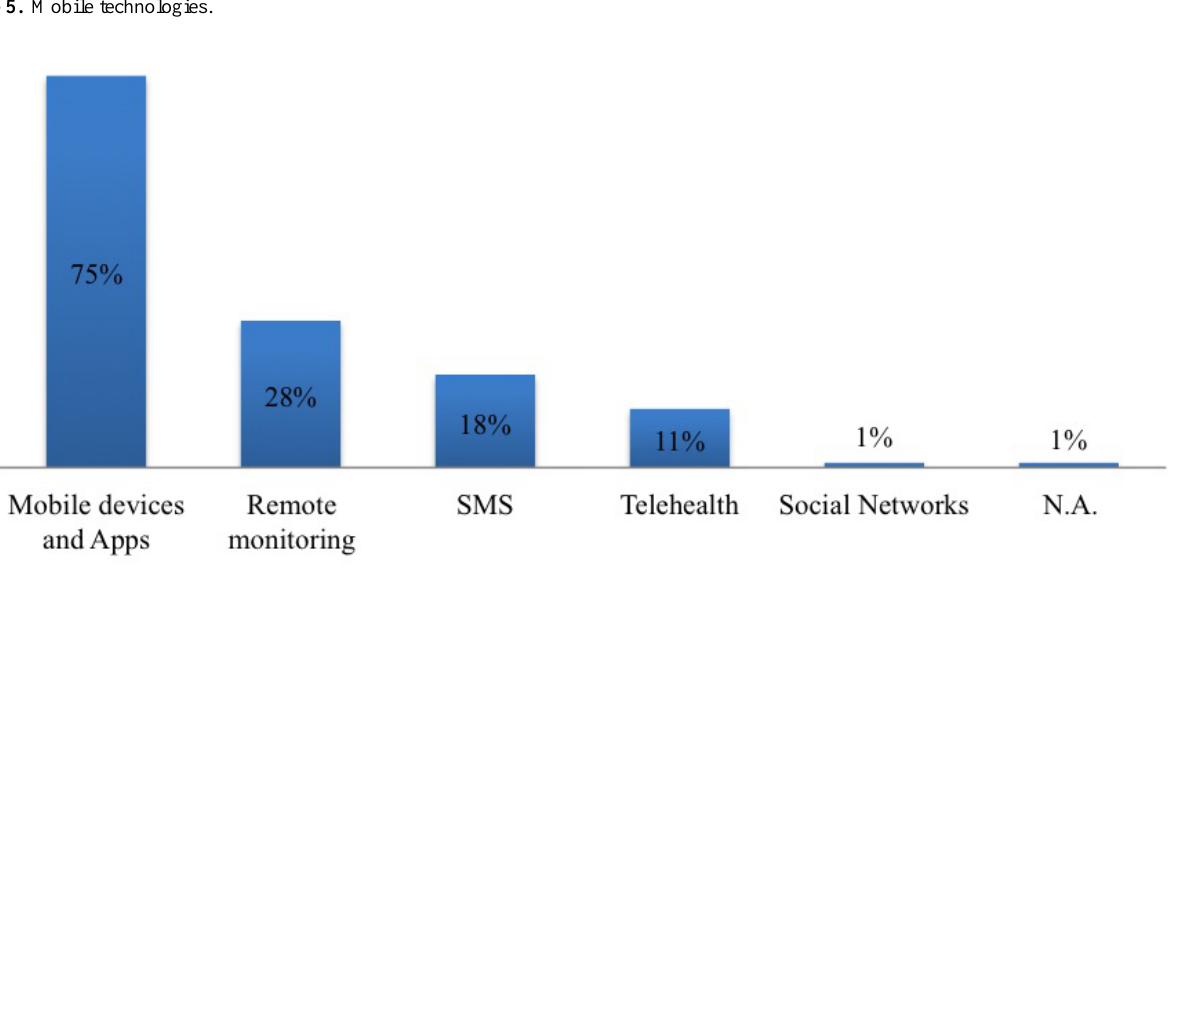
Figure 5. Mobile